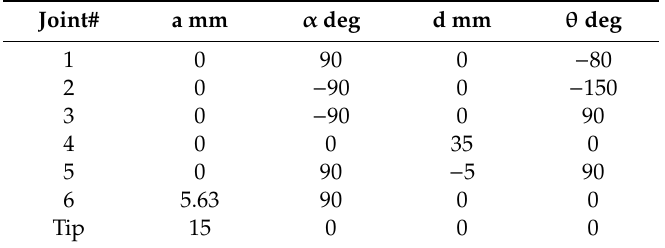
Table 4. Denavit–Hartenberg (DH) parameter of Condition